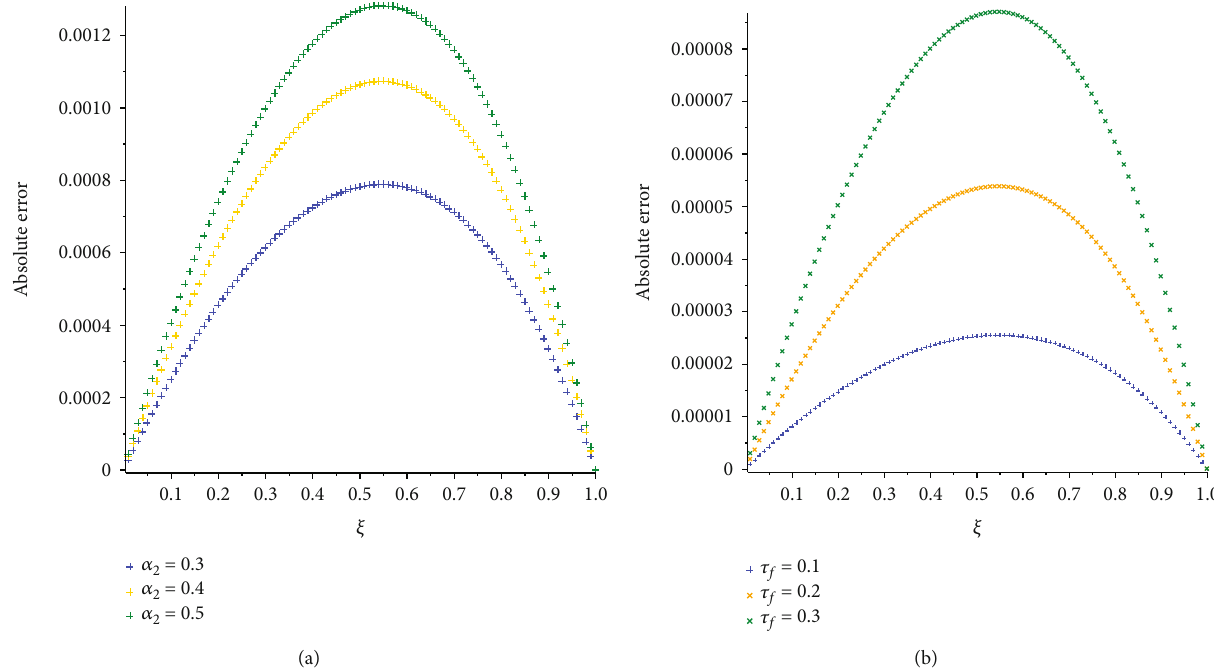
τ (b) Example 2. 2 (a) and f